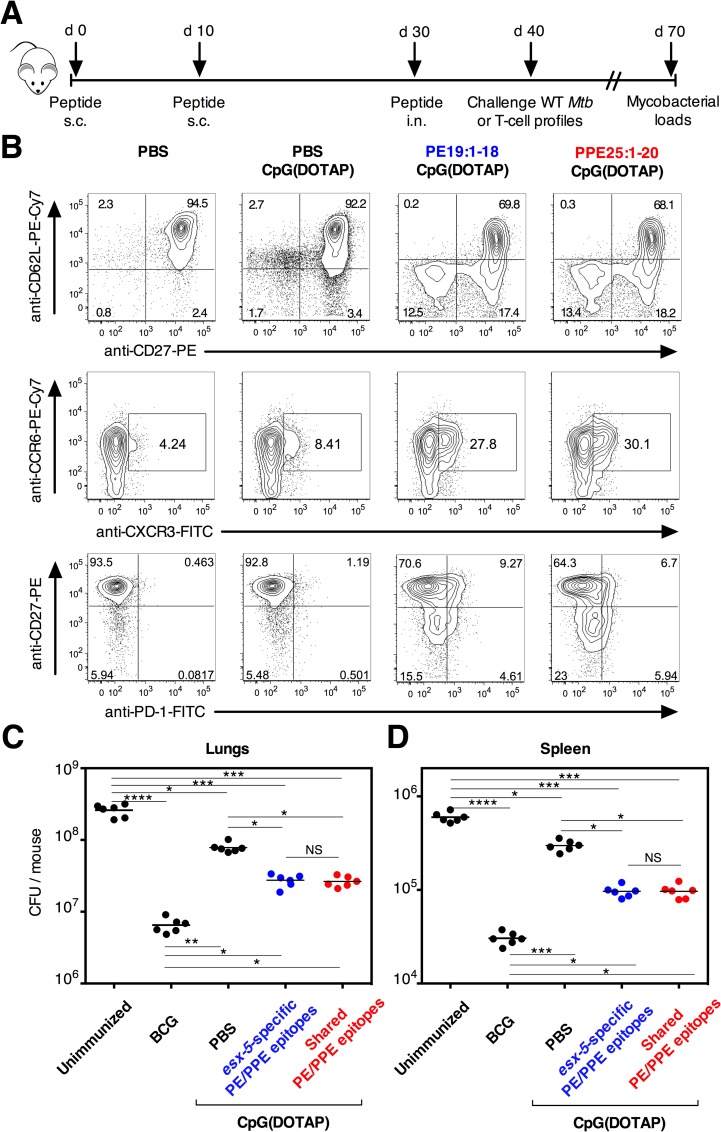
Evaluation of the protective effect of PE/PPE immunization against Mtb infection.A) Immunization regimen with PE/PPE-derived peptides. C57BL/6 mice (n = 6 per group) were injected with PBS or vaccinated twice s.c. at 10-days interval with individual or mixtures of selected PE/PPE-derived peptides, formulated in CpG(DOTAP). Peptide-immunized mice were boosted with the same individual or mixted PE/PPE peptides, formulated in CpG(DOTAP), via i.n. route at day 30. B) Expression of T-cell activation/migration/differentiation markers by the lung CD3+ CD4+ T cells in PE/PPE-immunized or the control mice, as studied ex vivo at day 40. See furthermore S8A Fig. C-D) Protective potential of such immunization against an aerosol challenge with virulent Mtb. Mice were immunized according to (A) with PE/PPE peptide mixtures of (i) esx-5-specific epitopes (PE19:1–18, PPE25:281–295 and PPE25:236–255 peptides), or (ii) shared epitopes (PE19:34–51, PPE25:1–20 and PPE25:201–215 peptides). They were then challenged at day 40 via aerosol route with ≈ 200 CFU/mouse of Mtb H37Rv WT strain. One month post-challenge, the mycobacterial loads were determined in the lungs (C) and spleen (D) of individual mice. NS = not significant, *, **, ***, **** = statistically significant, as determined by One Way ANOVA test with Tukey’s correction for multiple comparisons, p<0.05, p<0.005, p<0.001 or p<0.0001, respectively.